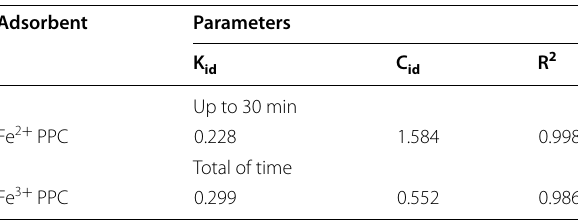
Table 3 The intraparticle diffusion kinetic data for adsorp- tion of Pb 2 + ions on iron modified pomegranate peel car- bons